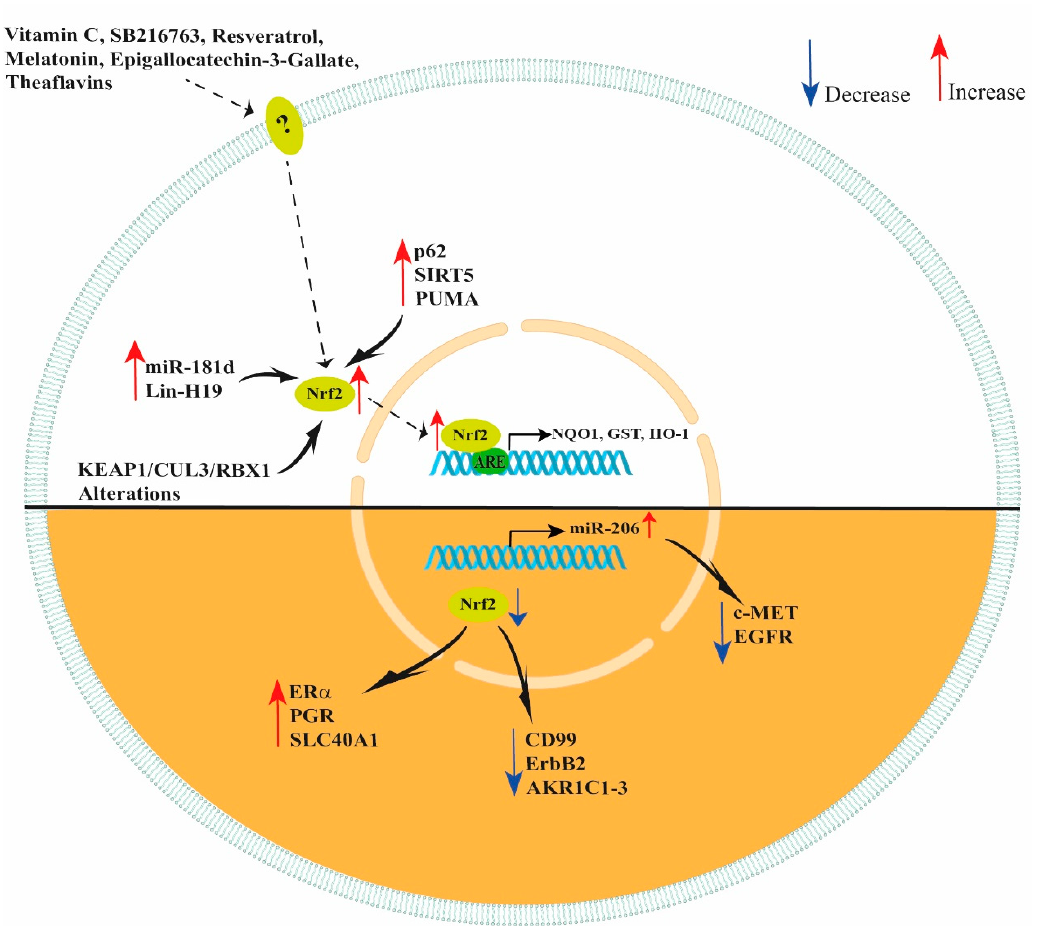
Figure 2. Schematic representation of NRF2 modulation. Vitamin C, SB216763, resveratrol, melatonin, epigallocatechin ‐ 3 ‐ gallate and theaflavins increase NRF2 expression in ovarian cells improving their response to oxidant agents. In ovarian cancer cells, increased levels of miR ‐ 181d, Lin ‐ H19, p62, SIRT5, PUMA and KEAP1/CUL3/RBX1 alterations lead to an increase in NRF2 expression. However, decreased levels of NRF2 lead to an increased expression of ER α , PGR, SLC40A1, miR ‐ 206 and decreased expression of CD99, ErbB2 and AKR1C1 ‐ 3. In addition, NRF2 indirectly decreases c ‐ MET and EGFR expression by increasing miR ‐ 206 levels.